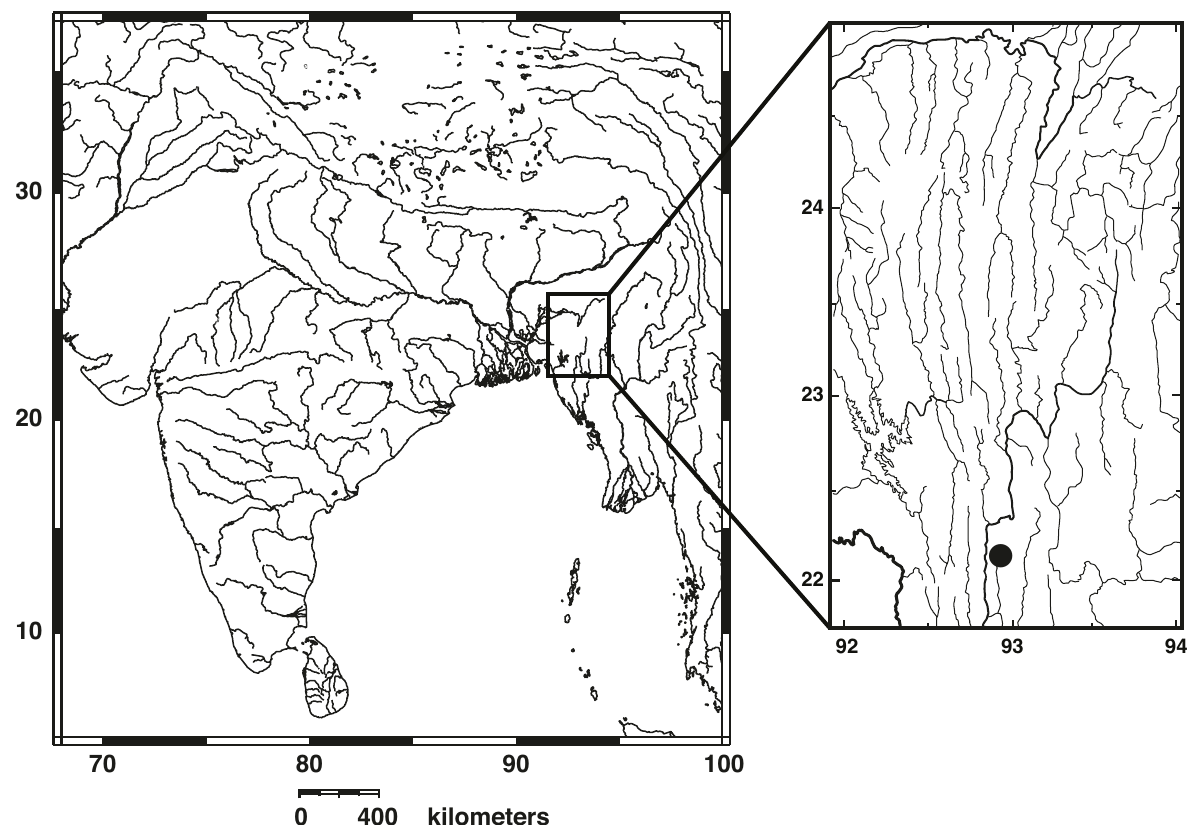
Figure 1. Map showing type locality of Eutropiichthys cetosus sp. nov.